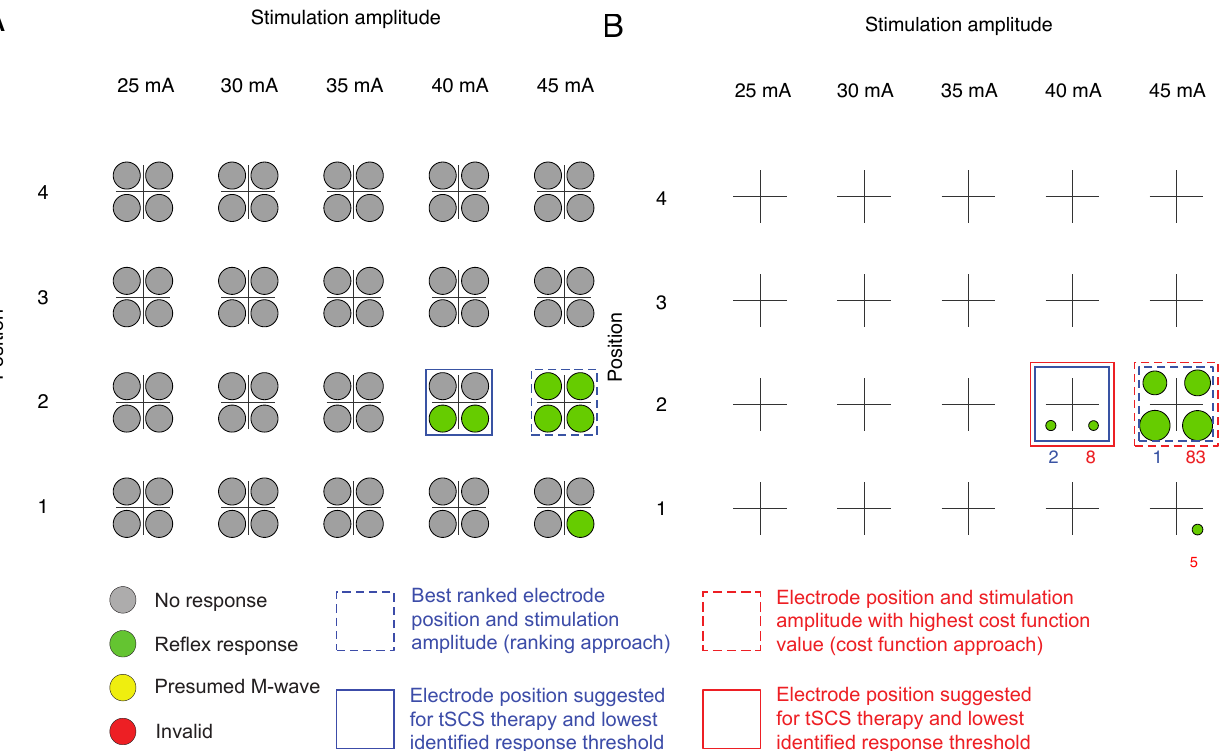
Figure A3. Comparison of ranking based on the two automatic response evaluation approaches applied. ( A ) Rating